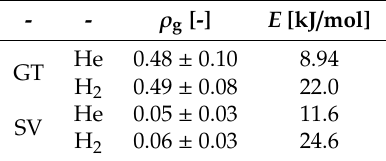
Figure 13. Temperature dependency of simulated ( a ) diffusion coefficient and ( b ) permeability of helium and hydrogen through a virtual amorphous silica membrane. Table 7. Values of the adjusted geometrical factor, ρ g , and activation energy, E.